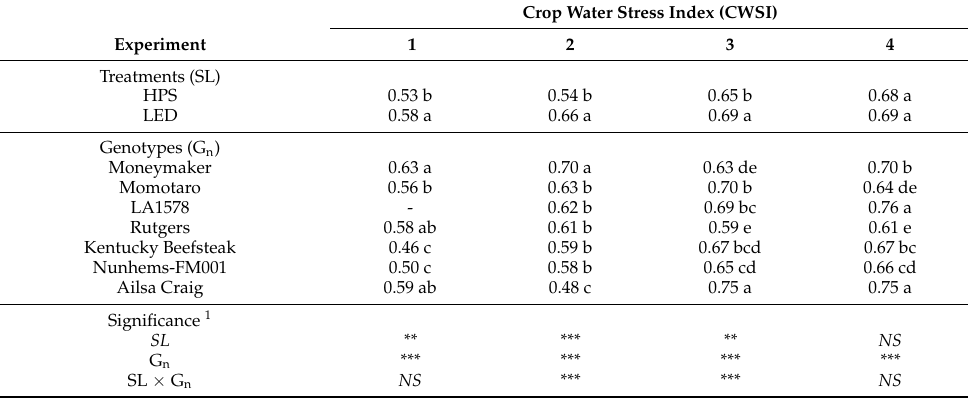
Table 4. Crop water stress index (CWSI) in seven tomato genotypes grown under HPS and LED supplemental light, in four experiments differing in fraction of SL over natural light (treatments: n = 21; genotypes: n = 3). Significance was tested by two-way ANOVA. Means followed by different letters within a column indicate significant differences according to Fisher’s protected LSD test ( p = 0.05). SL—supplemental light treatments; G n —genotypes ; SL × G n —interaction between SL and